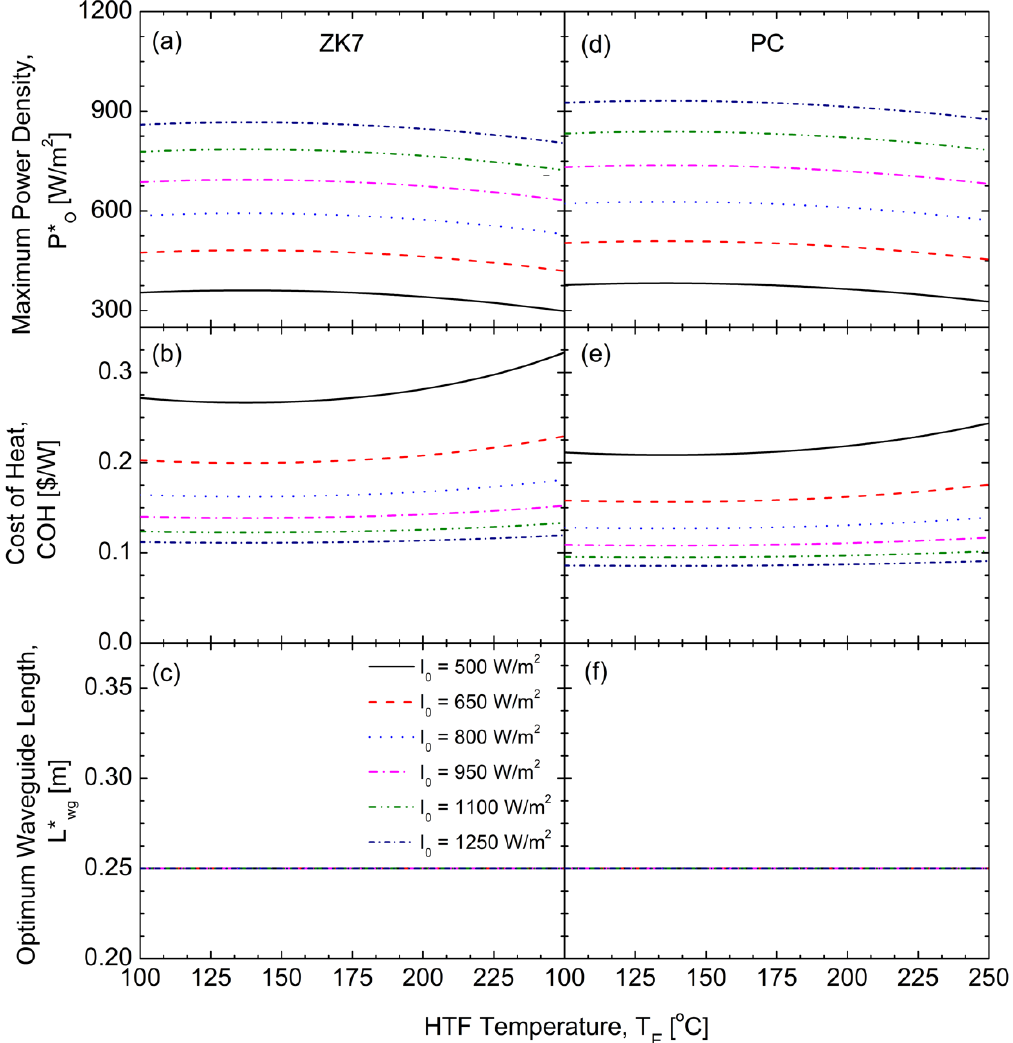
Figure 9. Numerical optimization results obtained for the maximum power density objective function: Optimal waveguide length and the corresponding performance metrics obtained from numerical optimization for ( a – c ) ZK7 and ( d – f ) PC waveguide for various incident irradiation and application temperature requirement represented by 𝑇 𝐹 .